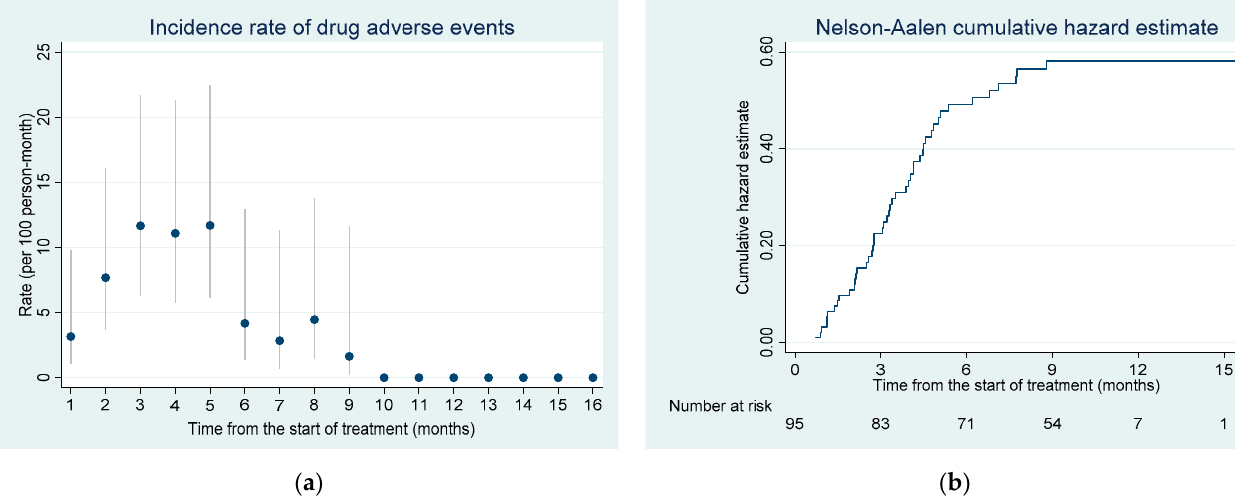
Figure 1. ( a ) Incidence rate of drug adverse events over the course of treatment; vertical lines indicate the 95% confidence interval; the incidence rate was estimated for monthly time intervals, for example the rate at month 3 indicates the period above 2 months and less or equal to 3 months; ( b ) cumulative hazard of drug adverse events since the start of the treatment among RR/MDR-TB patients enrolled in shorter treatment in Tashkent, Uzbekistan.